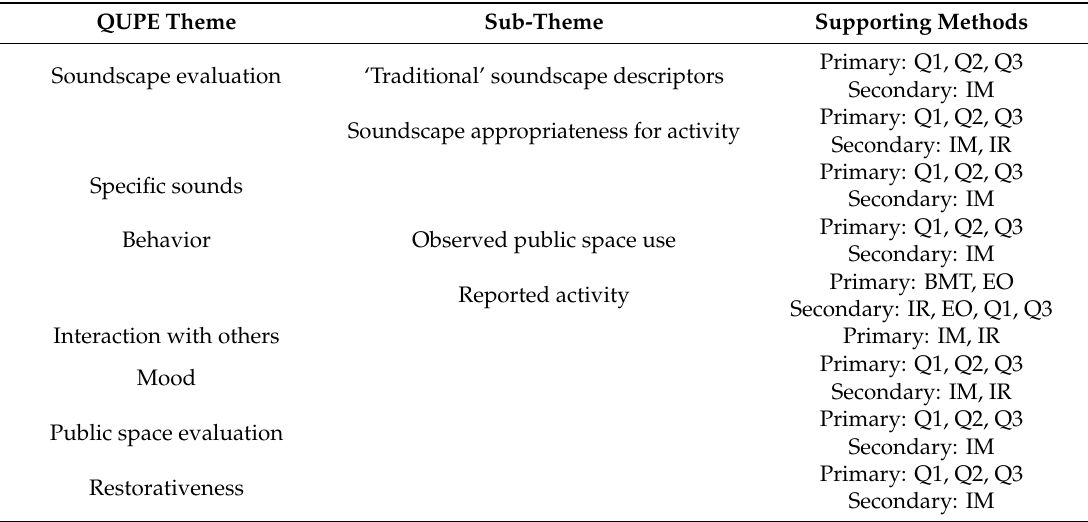
Table 1. Research methods supporting QUPE analysis. Secondary methods support the results of the primary methods in this mixed-method